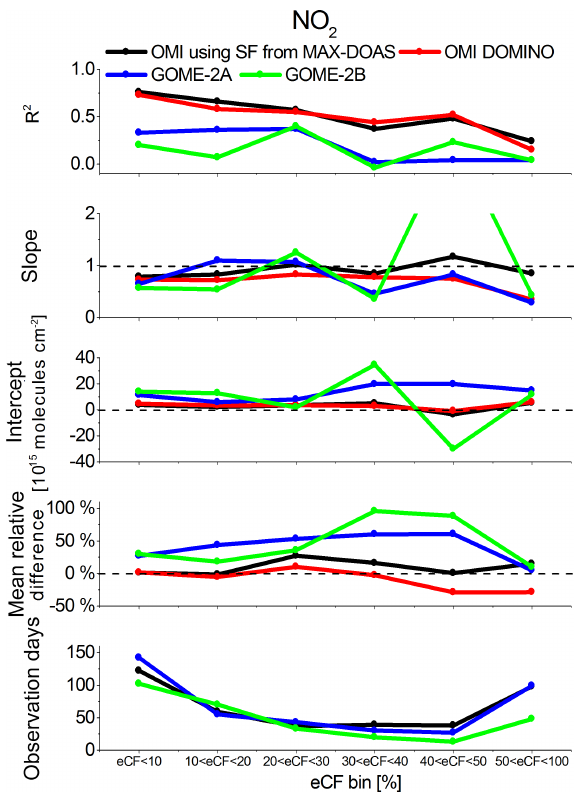
Figure 3. R 2 , slopes, intercepts, mean relative differences (and the number of available days) derived from the comparisons of the NO 2 VCDs from different satellite instruments to the MAX-DOAS re- sults for the different eCF bins. Note that the black and red curves represent the improved OMI VCDs with the a priori shape factors derived from Wuxi MAX-DOAS observations (see Sect. 3.2) and for the DOMINO 2 product,